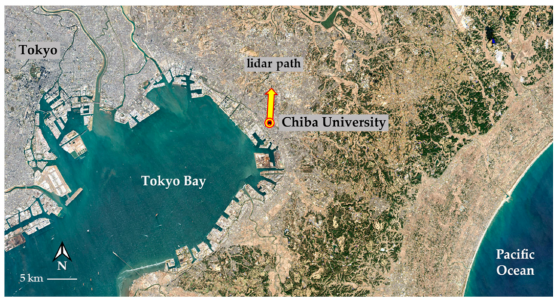
Figure 1. Map of the experiment site in Chiba, Japan. The circle mark represents the location of the lidar system inside the Chiba University (35.62 ◦ N 140.10 ◦ E) with ~5 km observation